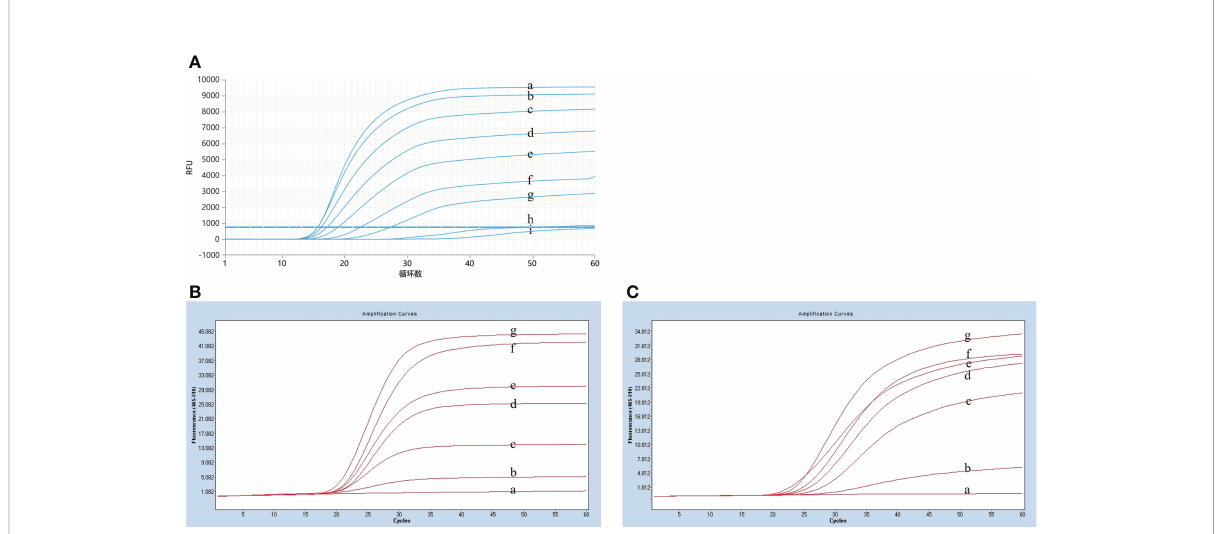
FIGURE 3 Results of reaction system optimization. (A) Optimization of temperature. (a) 58°C(b) 59°C, (c) 60°C, (d) 61°C, (e) 62°C, (f) 63°C, (g) 64°C, (h) 65°C, (i) 66°C. (B) Probe dosage optimization. (a) 0 µM, (b) 0.1 µM, (c) 0.2 µM, (d) 0.3 µM, (d) 0.4 µM, (e) 0.5 µM, (f) 0.6 µM, (g) 0.7 µM. (C) Optimization test for the RNase H2 enzyme. (a) 0 mU, (b) 1.25 mU, (c) 2.5 mU, (d) 3.75 mU, (e) 5 mU, (f) 6.25 mU, (g) 7.5 mU.